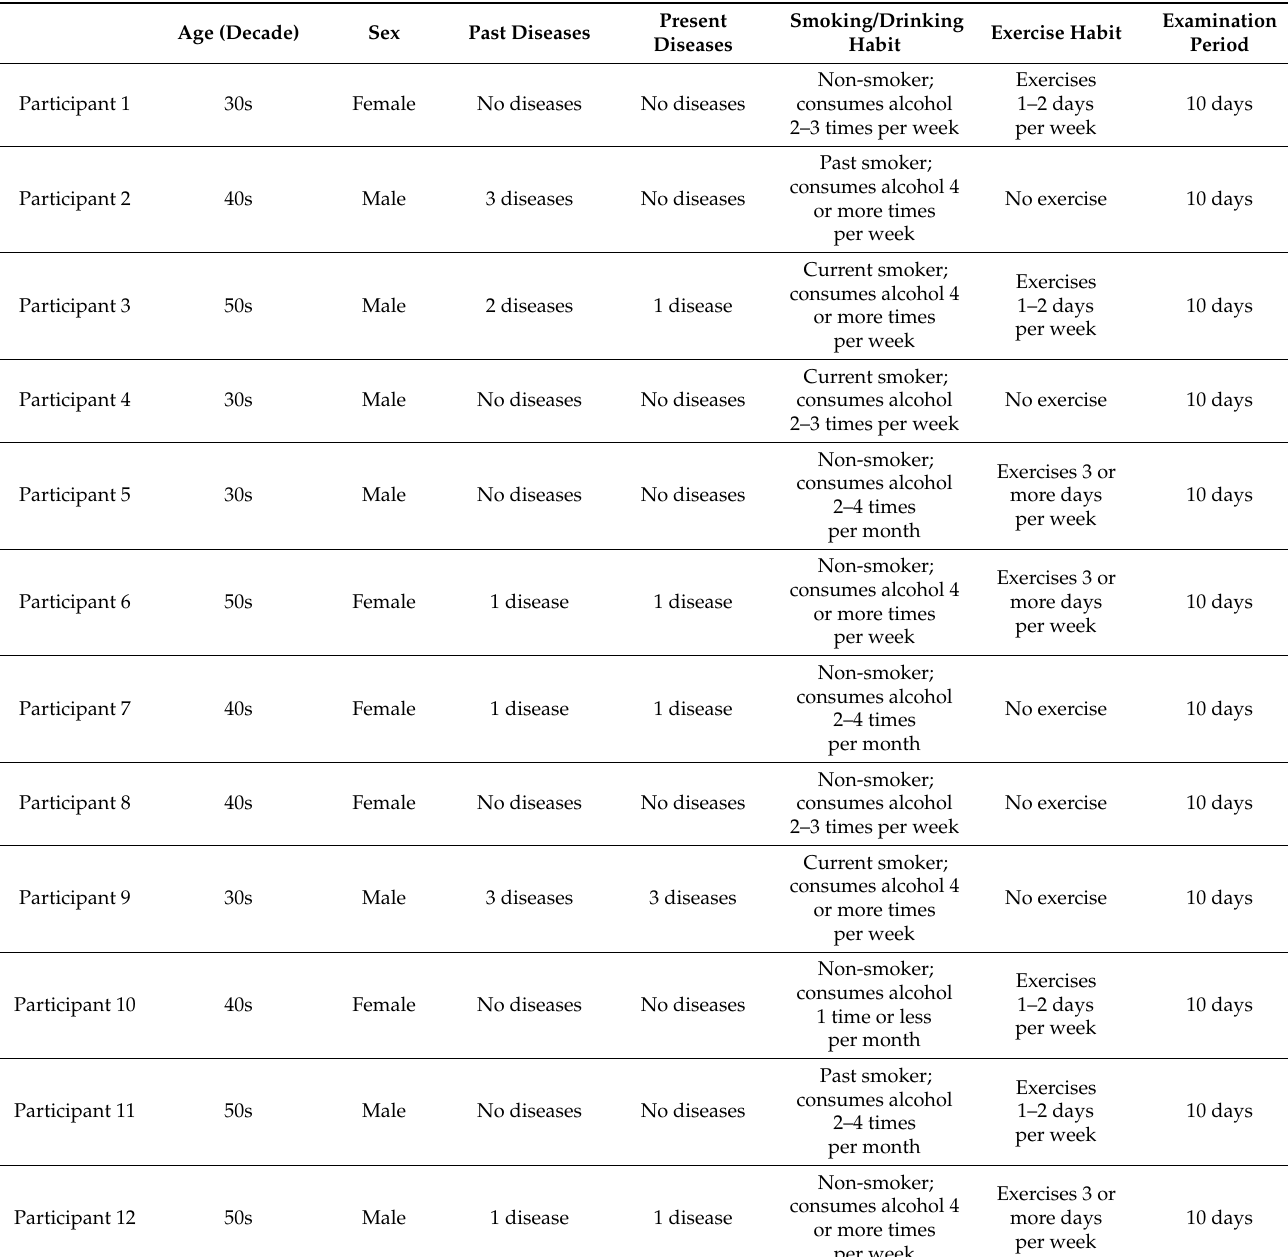
Table 1. Characteristics of the selected